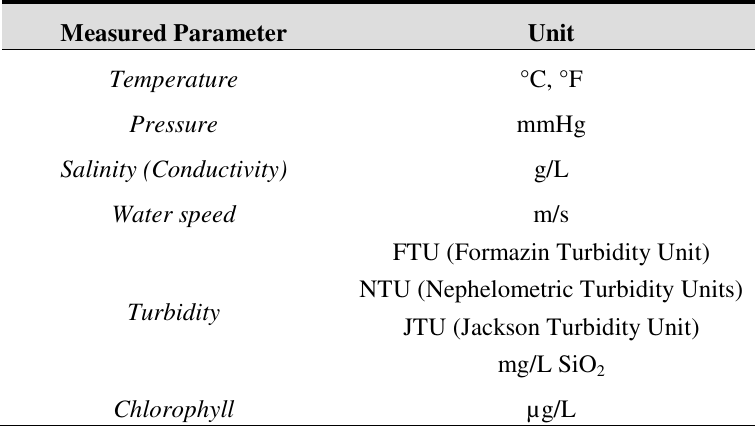
Table 2 . Common oceanographic